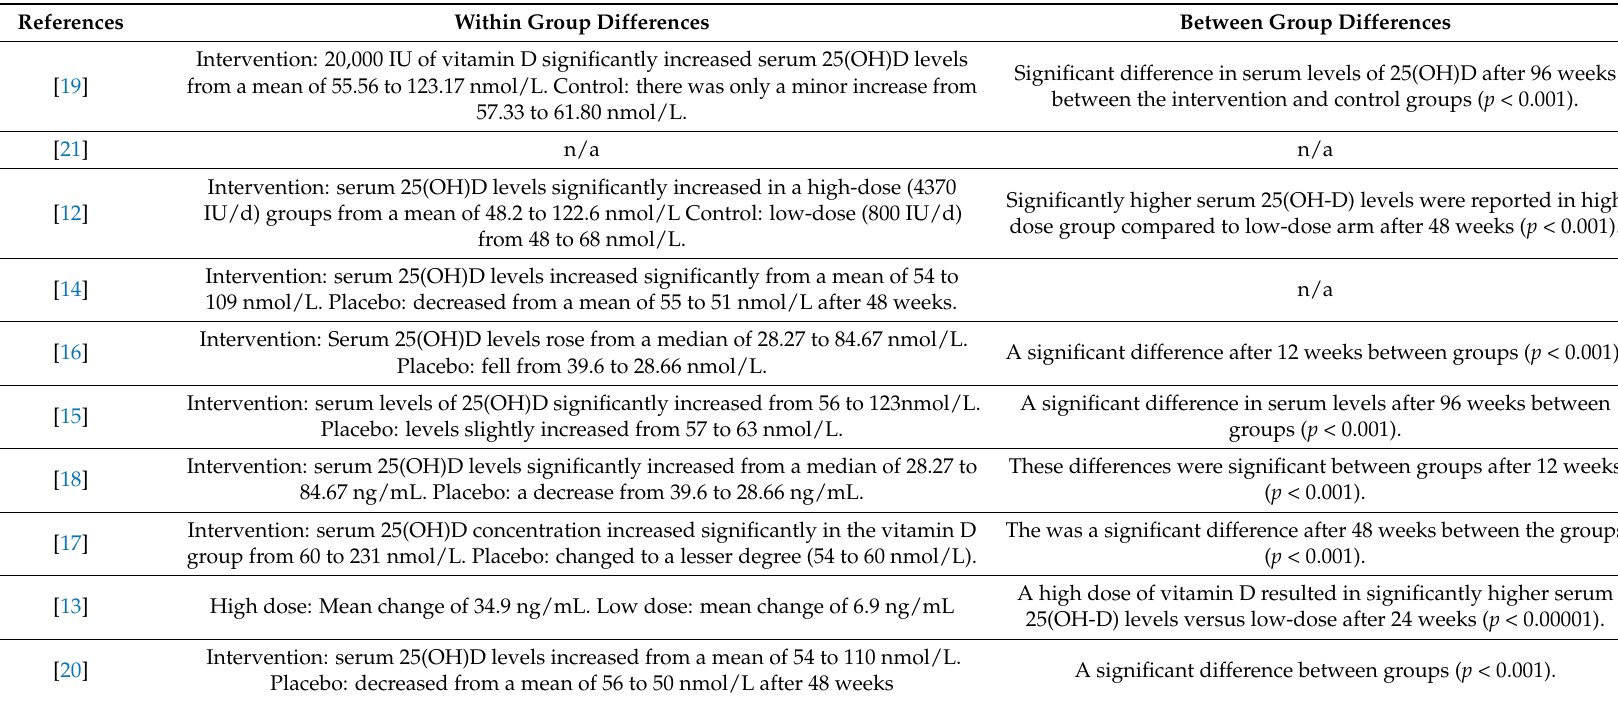
Table 4. Changes in serum 25(OH)D levels after intervention